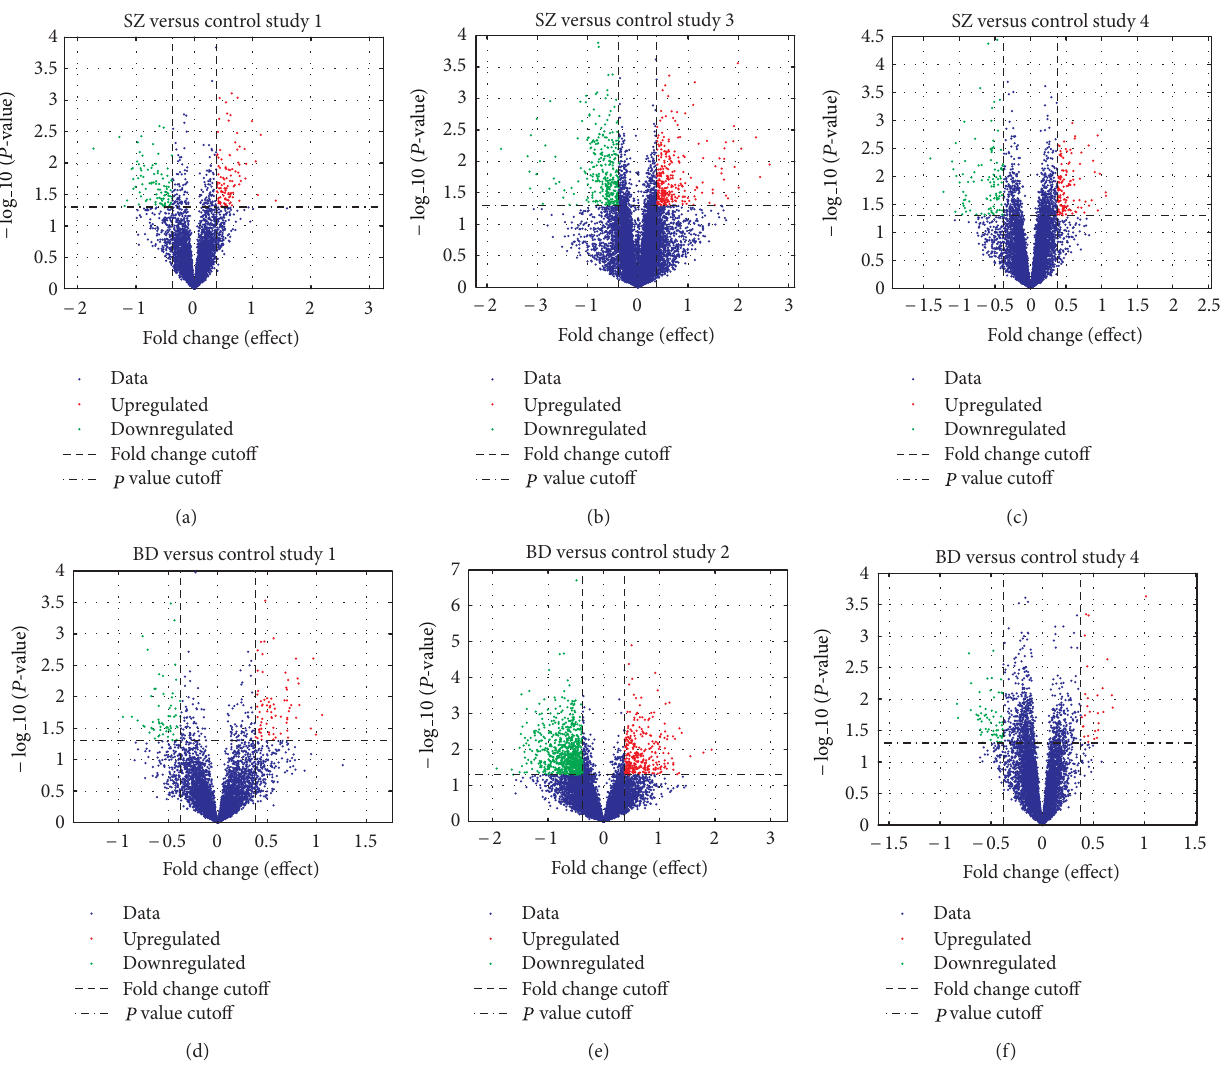
F 1: Volcano plots of DE probesets, generated from two-tailed Student’s t-test. Upregulated genes in the disease state are depicted with red-colored spots and downregulated genes with green-colored spots. e �rst three plots (a, b, c) represent DE genes in SZ patients from �rst, third, and fourth studies, respectively, and the following three plots (d, e, f) represent DE genes in BD patients from �rst, second, and fourth studies, respectively. FC ratio between gene expression in disease state and healthy state is depicted in the horizontal axes for each scale, and scale are depicted in vertical axes. All plots are similar in most studies, except for plot (e), which dataset in shows more green and red spots. is fact means that the number of DE genes is similar in most studies but in study 2 there is a greater number of statistically signi�cant genes in comparison to other 𝑃𝑃 −log 10 log 2